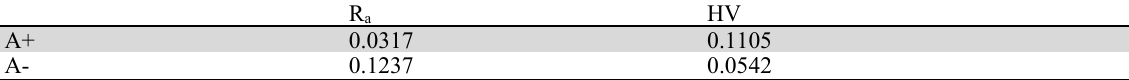
The best solution and the worst